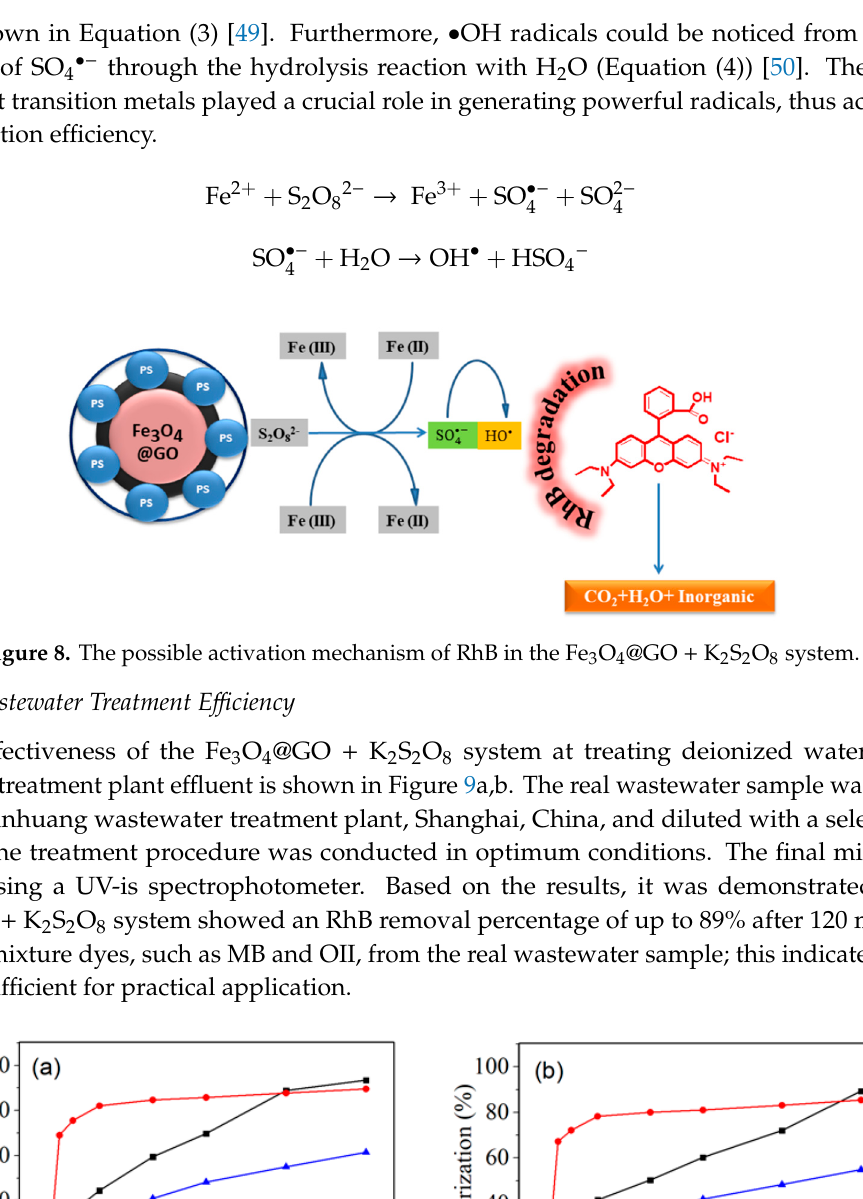
13 of 17 Figure 7. A full XPS spectra of Fe 3 O 4 @GO including O 1s, Fe 2p, and N 1s before and after the